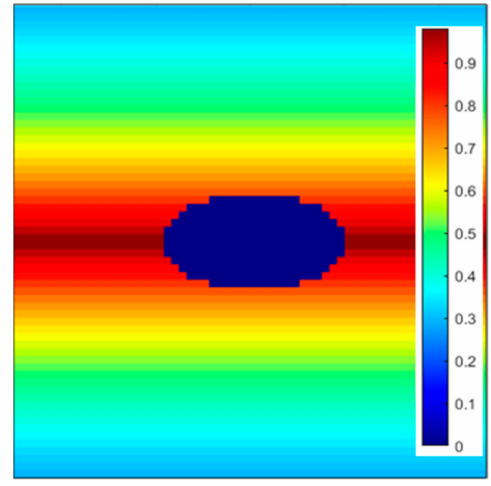
Figure 4. I Y field of an ellipse with AR = 4.